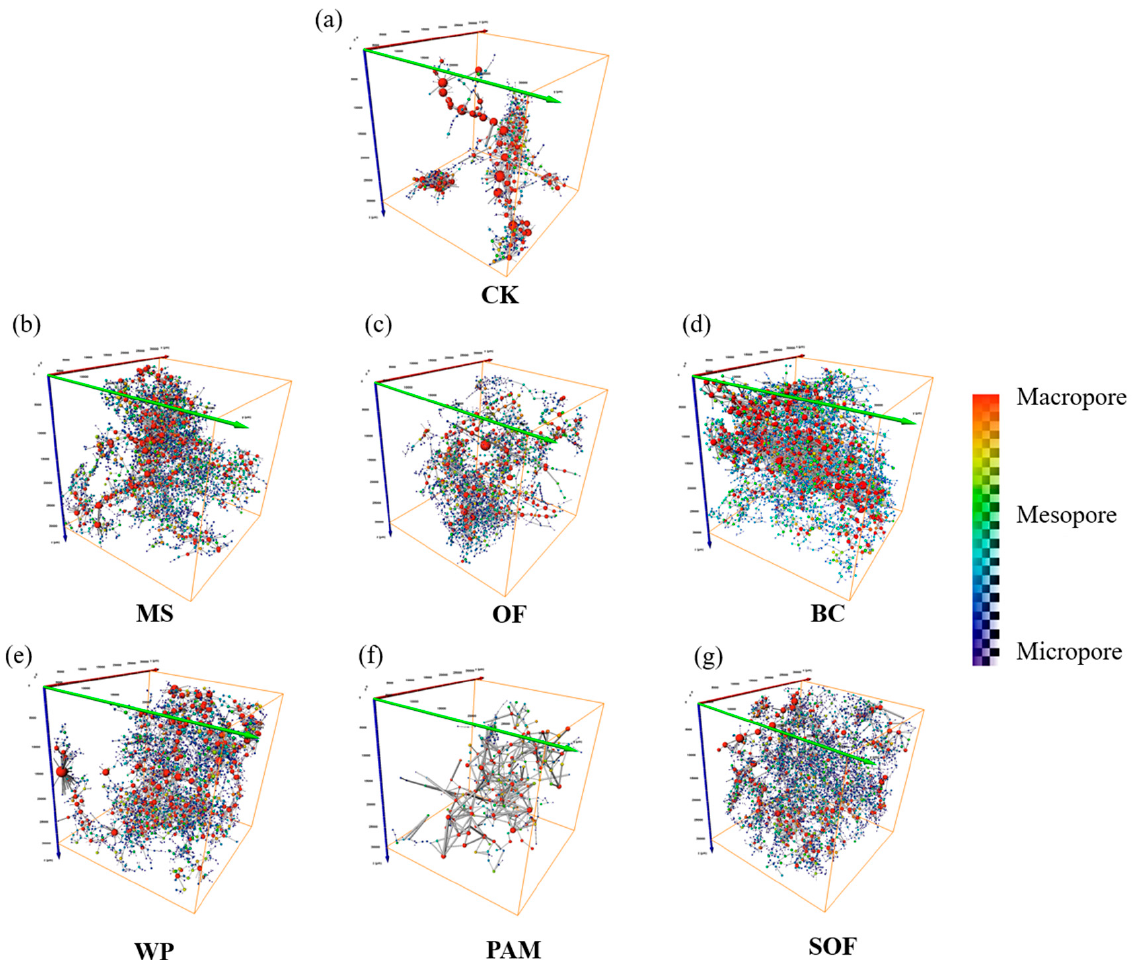
Figure 5. Representative 3D visualizations of soil pore networks under different treatments (physical size = 3 cm × 3 cm × 3 cm). Spheres represent node pores, and lines represent their connections. Warmer colors represent larger volumes, and cooler colors represent smaller volumes. ( a ) CK, with control, no organic material incorporated; ( b ) MS, maize straw; ( c ) OF, organic fertilizer; ( d ) BC, biochar; ( e ) WP, woody peat; ( f ) PAM, polyacrylamide; ( g ) SOF, maize straw and organic